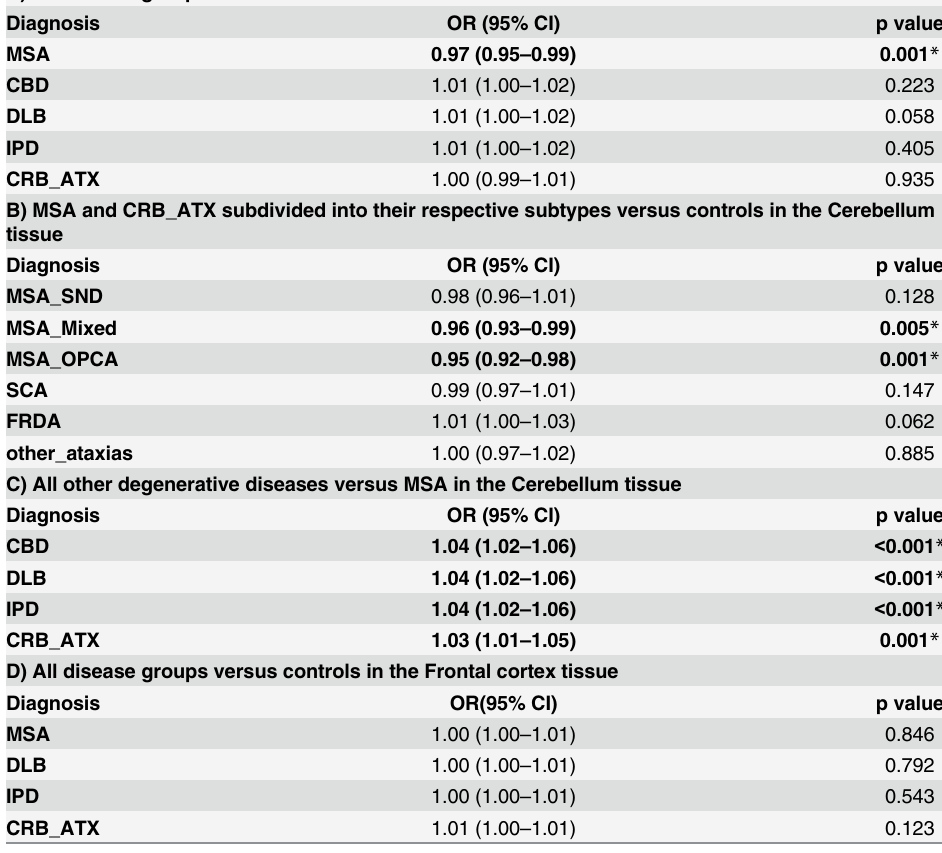
Table 2. Multinomial logistic regression estimates for the association between different diagnosis groups and CoQ10 levels in human brain tissue. A) All disease groups versus controls in the Cerebellum